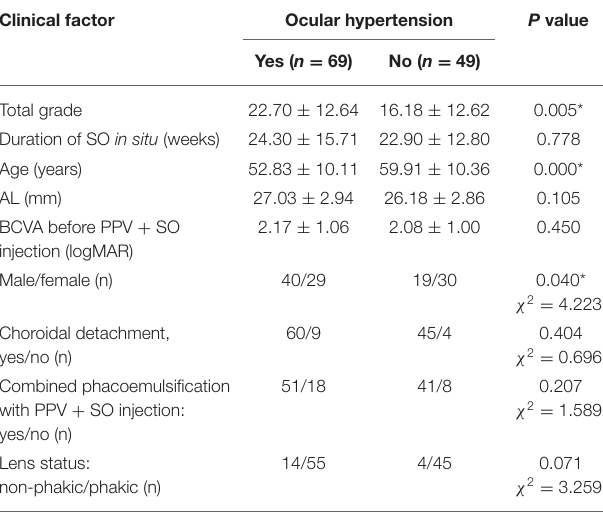
TABLE 3 | Comparison of clinical factors between patients with and without ocular hypertension (IOP > 21 mmHg or use of antiglaucoma medications). Clinical